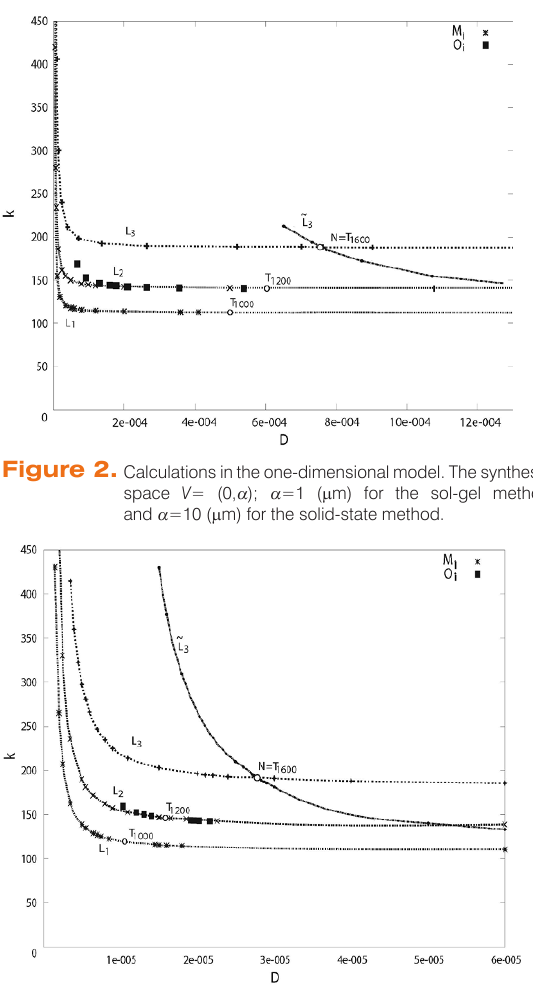
Figure 3. Calculations in the two-dimensional model. The synthesis space V = (0, a ) × (0, a ); a =1 ( m m) for the sol-gel method and a = ( m m) for the solid-state